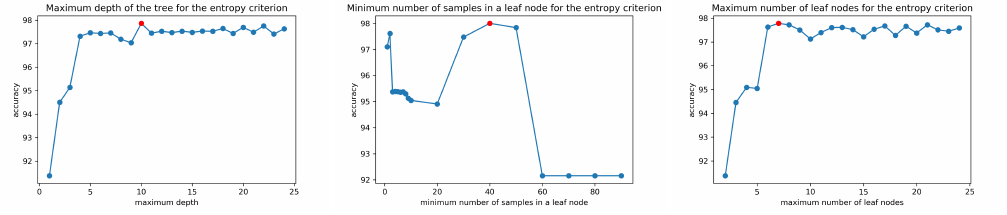
Figure 8. Simulation results for generalization purposes of the CART-E tree: ( left )-max depth of the tree, ( middle )-max number of samples in a leaf node, ( right )-max number of leaf